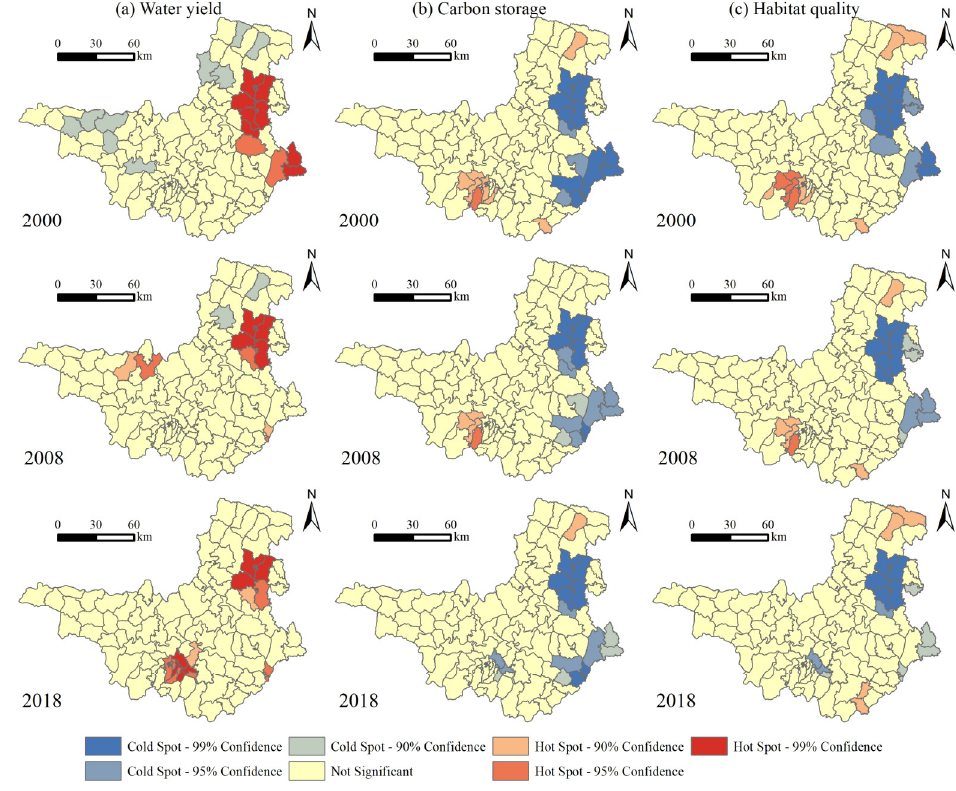
Figure 5. Hotspot distribution of ecosystem services in the Danjiangkou reservoir area from 2000 to 2018.